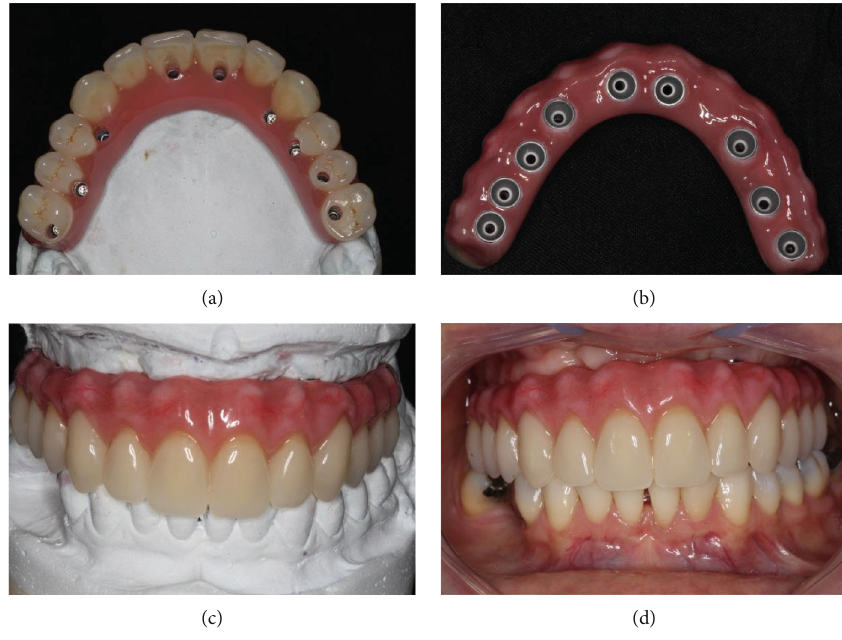
Figure 10: The de fi nitive prosthesis was installed.